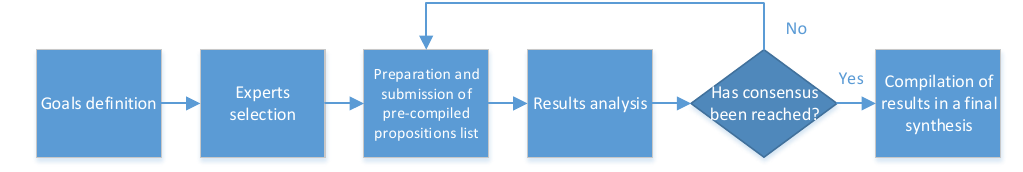
Figure 4. The generic process of a Delphi study.